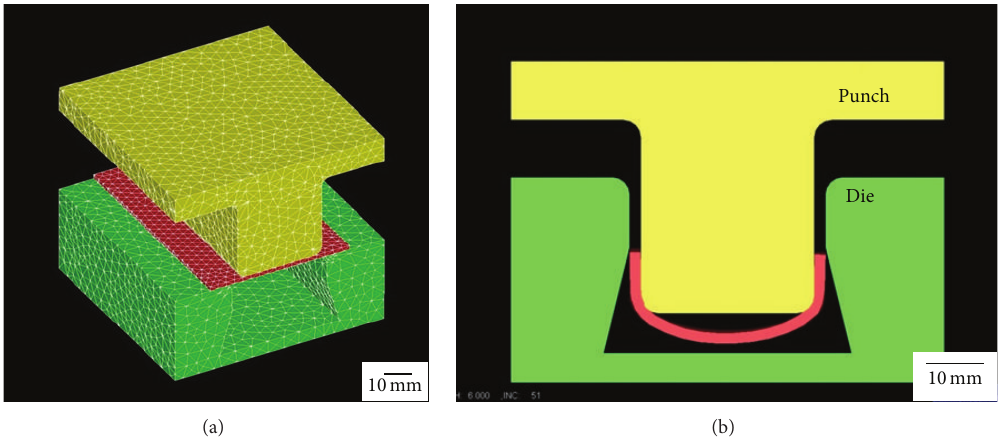
Figure 3: Numerical simulation—tooling and blank: before hot stamping (a) and after hot stamping (b).